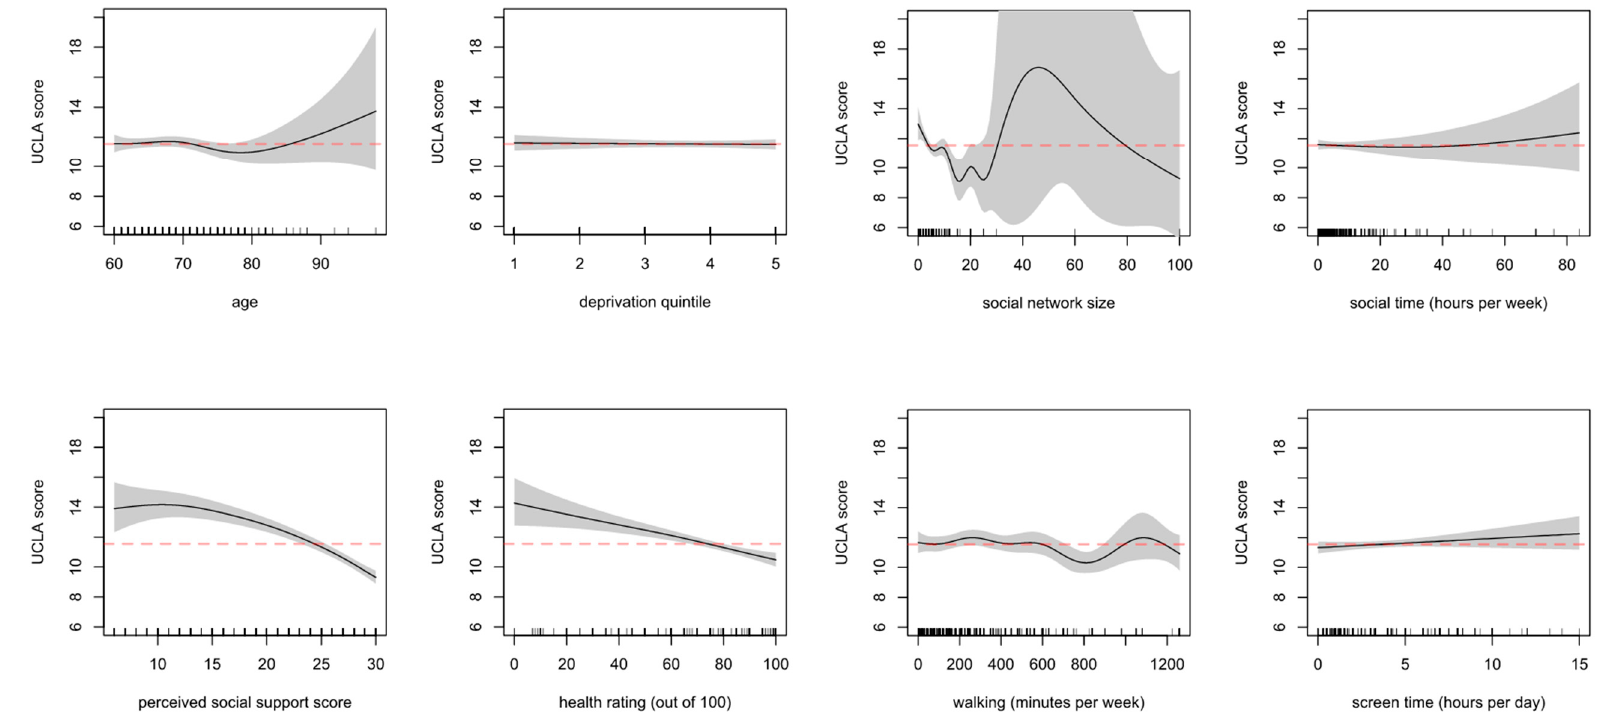
Figure 3. Associations with loneliness (UCLA) for continuous and ordinal variables on the outcome scale, from top left to bottom right: age, deprivation quintile, social network size, social time. From bottom left to bottom right: perceived social support (BPSSQ score), health rating, self-reported walking, and screen time. The dashed line indicates the model intercept (the model average when all other covariates are kept at their average/reference level)